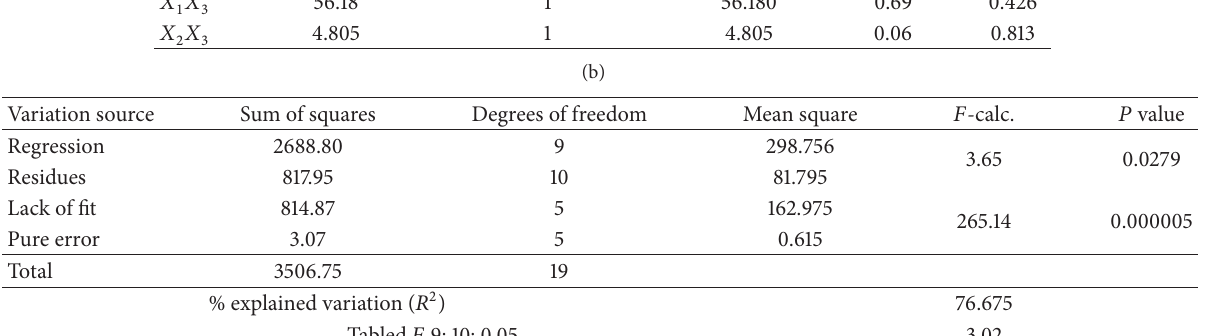
Based on these results, it is evident that